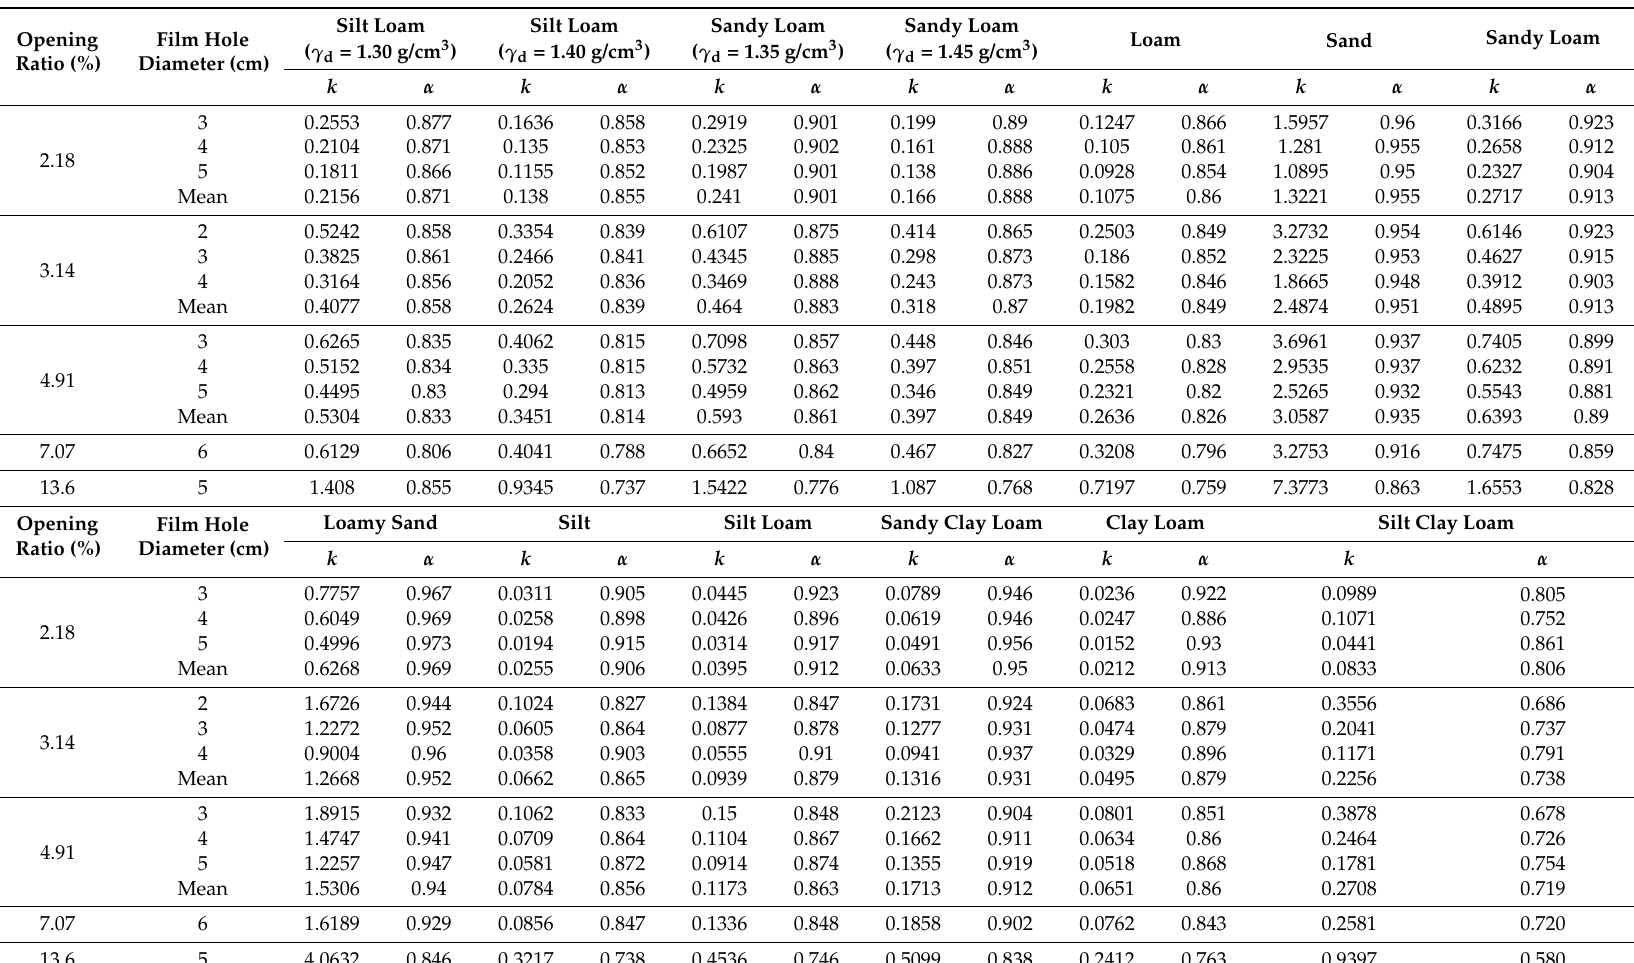
Table 4. Fitted infiltration parameter